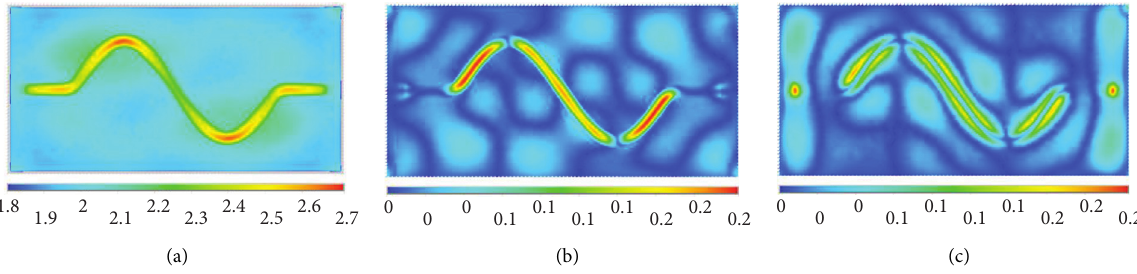
u u x , (b) y , and (c) z